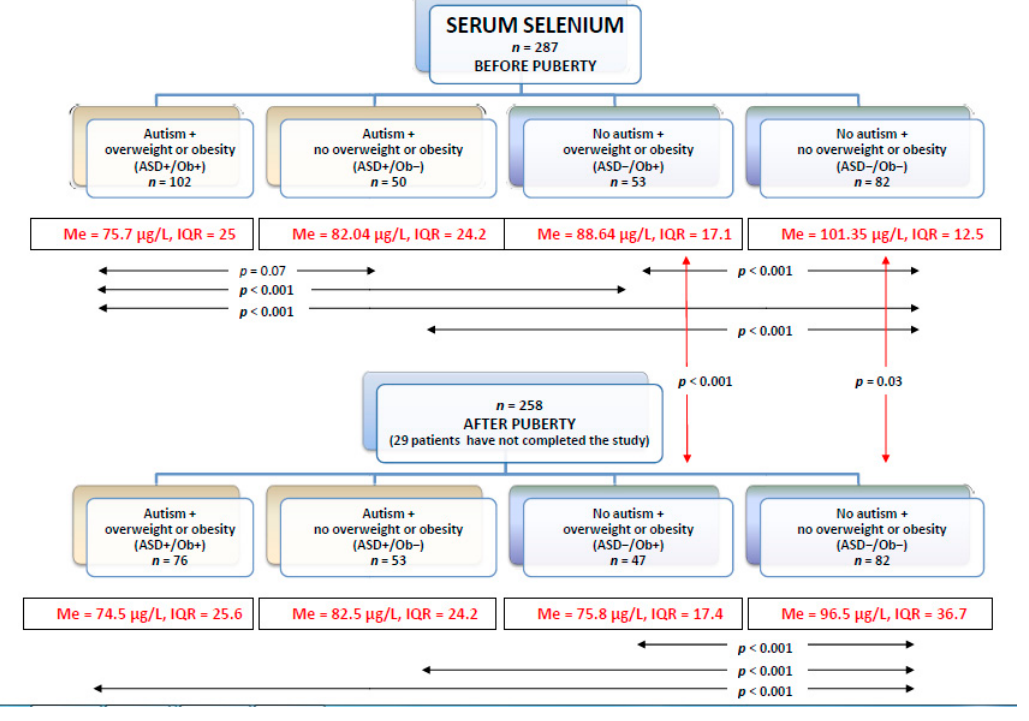
Figure 2. The serum selenium levels in each group before and after puberty (Me—median, IQR— interquartile